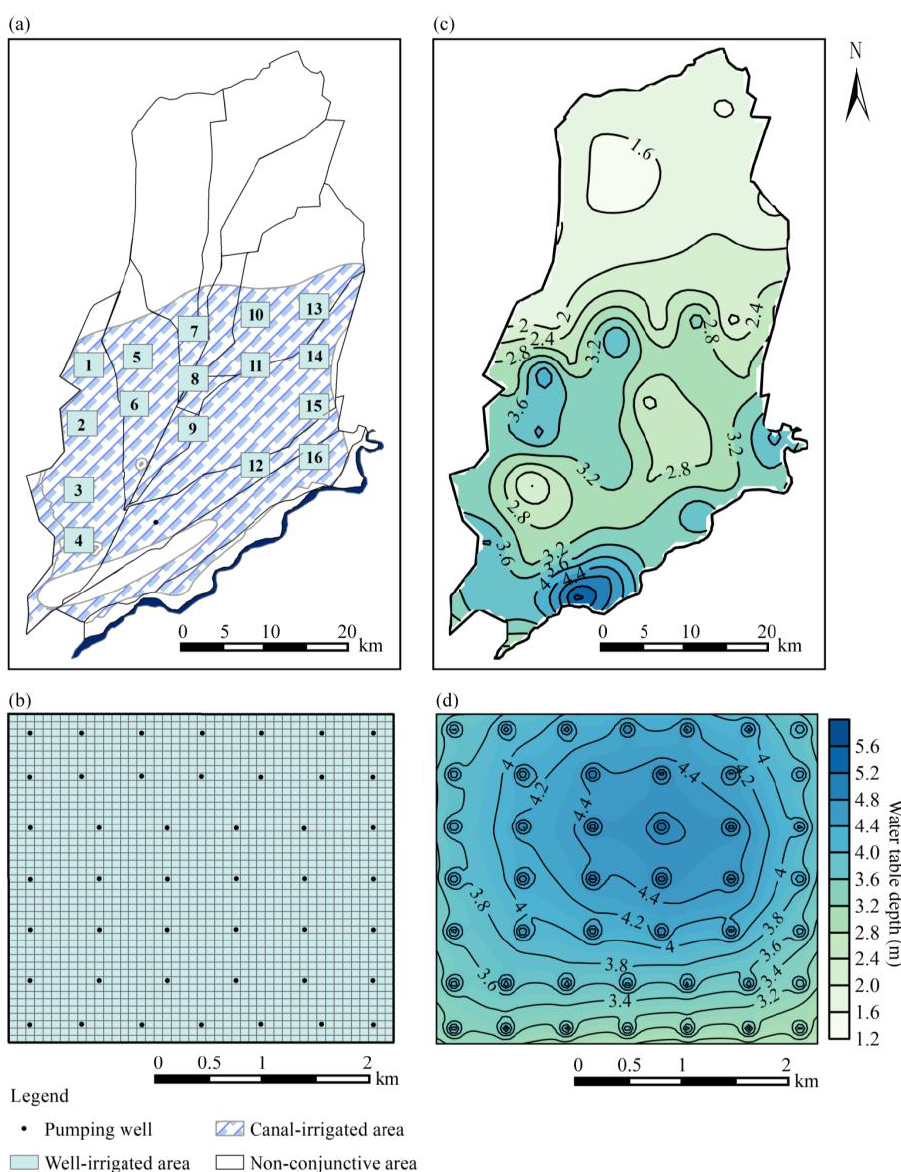
Figure 10. The predicted water table depth in Yongji sub-irrigation district after well-canal conjunctive irrigation, ( a ) layout scheme of well-irrigated areas, ( b ) pumping wells in a well-irrigated area, ( c ) spatial distribution of water table depth during the growth period of Yongji sub-irrigation district under the well-canal conjunctive irrigation, and ( d ) spatial distribution of water table depth during the growth period of one well-irrigated area.